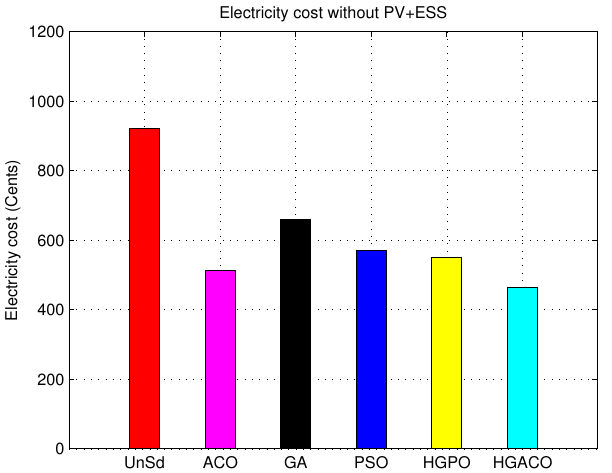
Figure 10. Aggregated electricity cost without photovoltaic-battery systems.